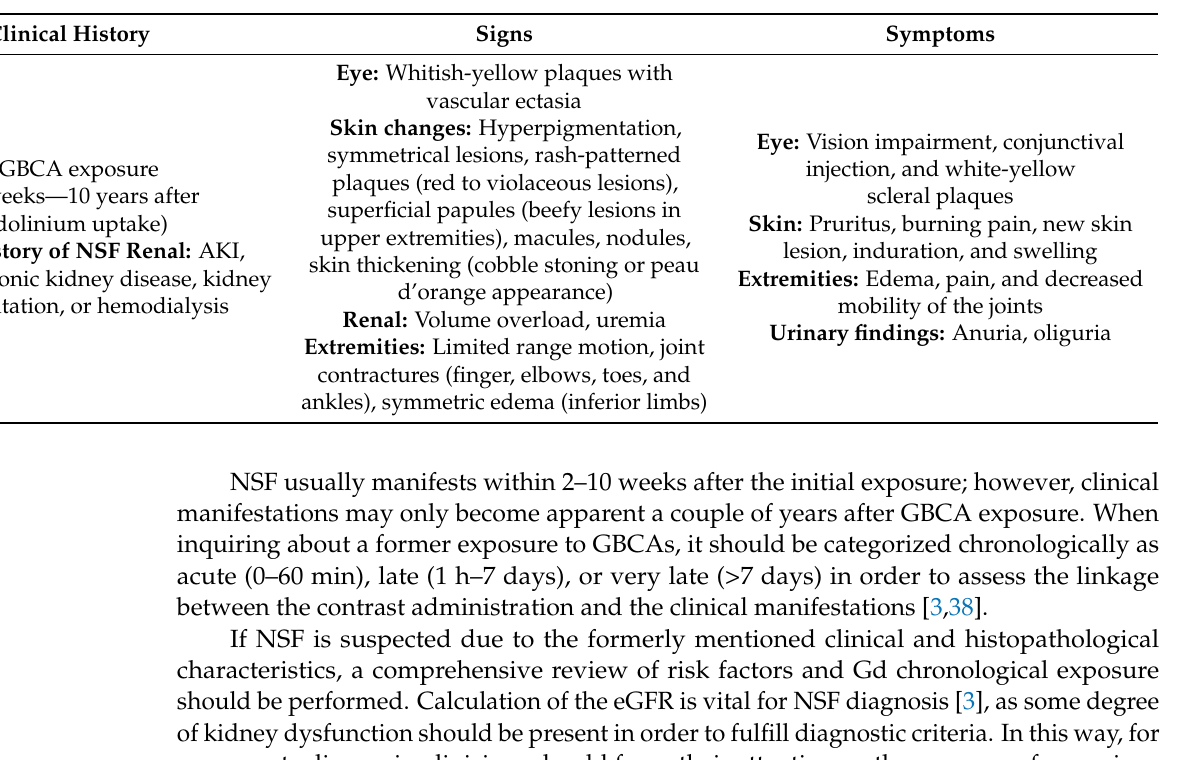
Table 4. Signs and symptoms of NSF